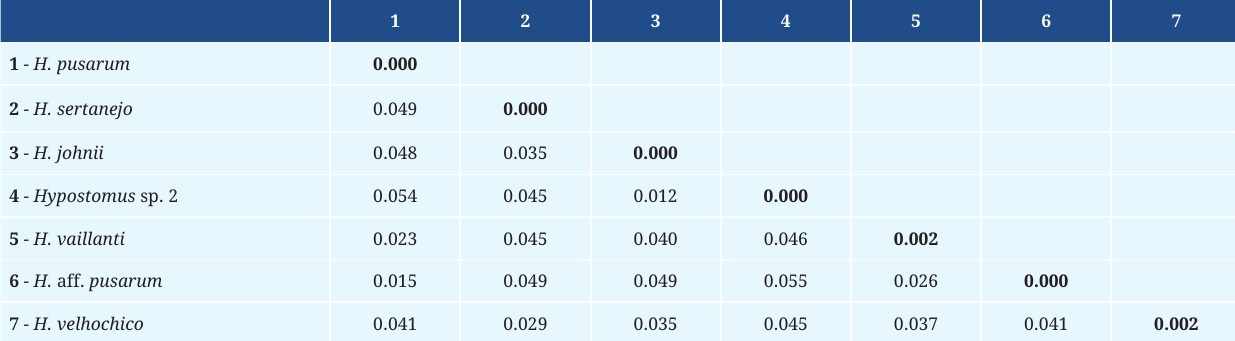
FIGURE 2 | Phylogenetic tree with Bayesian inference for the mitochondrial cox 1 gene, including species of Hypostomus that occur in the Parnaíba River (in bold), and other comparative species of the surrounding ecoregions: ( H. pusarum and H. sertanejo from the Mid-Northeastern Caatinga) and H. velhochico from São Francisco ecoregion. The numbers above the branches are later probability values. H: Holocene. TABLE 1 | Genetic distances (Kimura 2 parameters) between species of the genus Hypostomus from the Parnaíba River basin (Maranhão-Piauí ecoregion), and some species of the São Francisco and Mid- Northeastern Caatinga ecoregions. Bold diagonal numbers refer to intraspecific 1 2 3 4 5 6 7